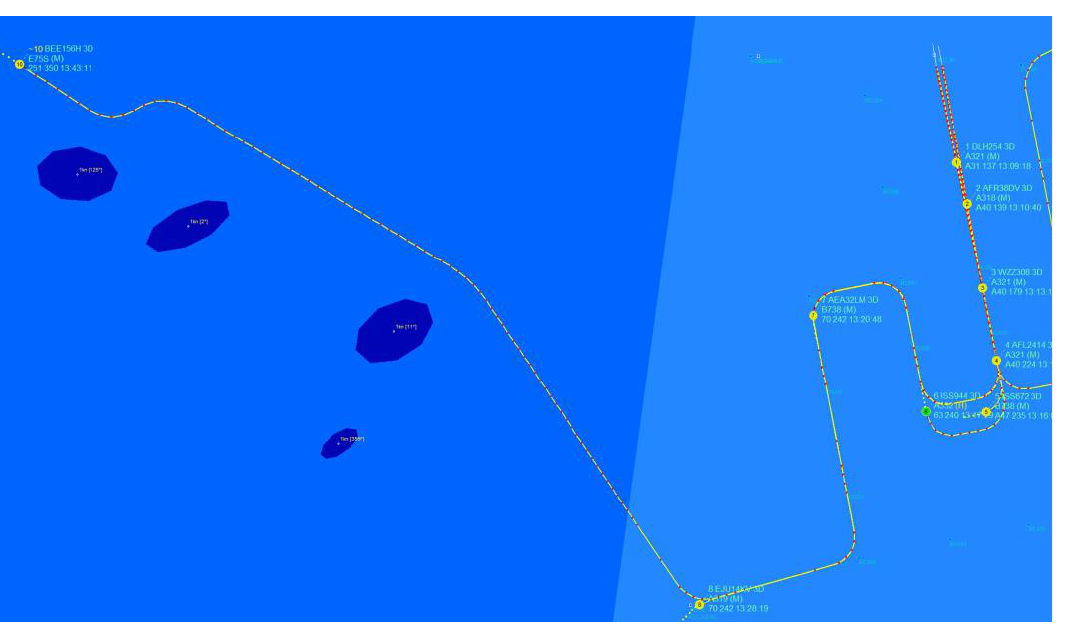
Figure 19. Route calculation for aircraft BEE156H approaching MXP from the northwest through a loose group of convective areas. If several convective cells occur as a group, the AMAN tries to guide aircraft around them as a whole. MXP traffic mix from 11 May 2019 with weather from 6 August 2019 and the RaNDeVIL nowcast